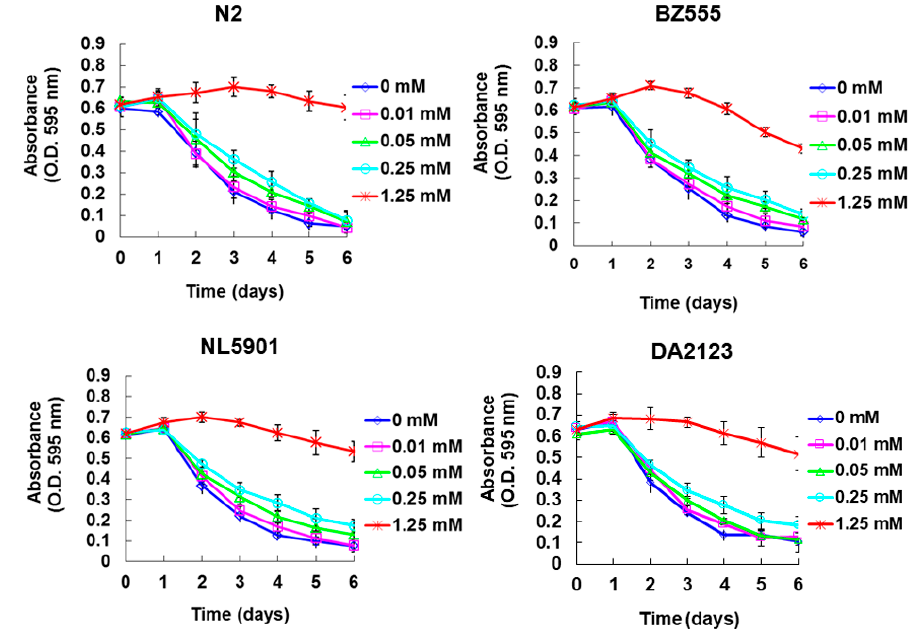
Figure 2. The concentration of maackiain (MK) used in the C. elegans model was determined by a food clearance test. In a 96-well plate, synchronized L1 worms of N2, BZ555, NL5901, and DA2123 strains were cultured with E. coli in OP50 (OD A 595 = 0.6) feeding medium containing 0, 0.01, 0.05, 0.25 or 1.25 mM MK for 6 days. During this period, the OD value of each treatment was measured and recorded daily.